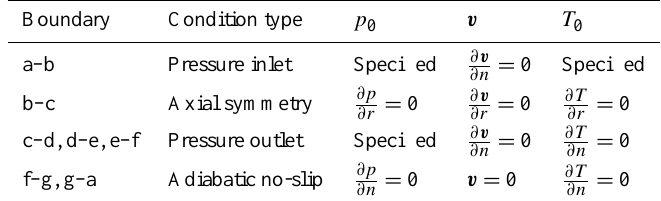
Table 3. Boundary conditions for the axisymmetric calculation.